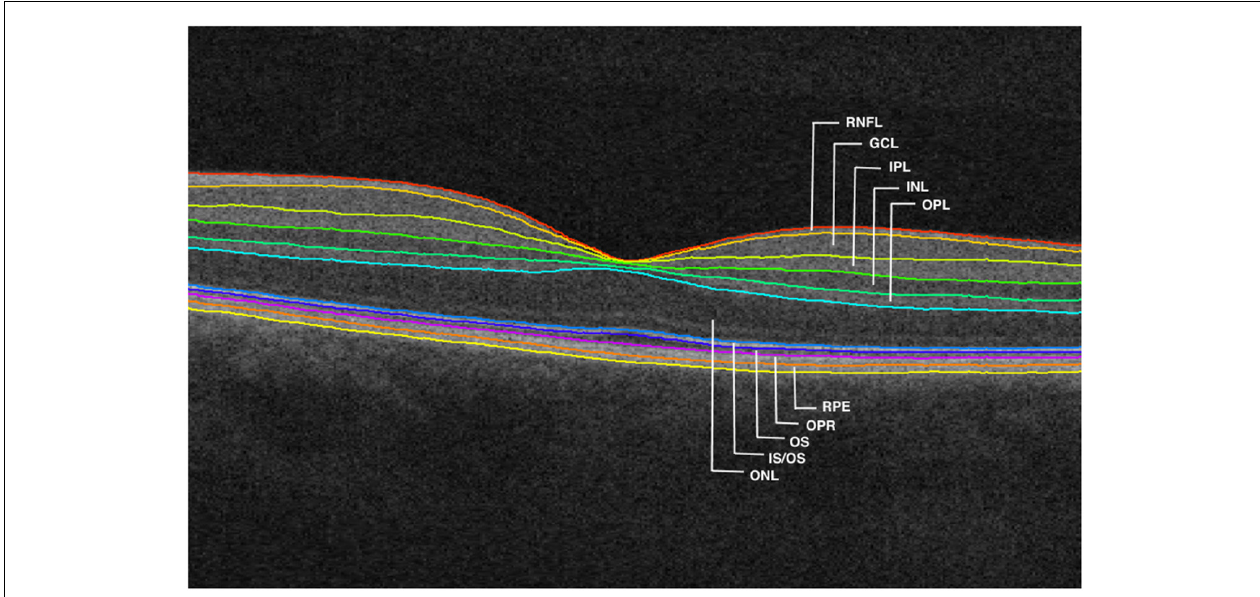
FIGURE 2 | Segmented retinal layers: retinal nerve fiber layer (RNFL); ganglion cell layer (GCL); inner plexiform layer (IPL); inner nuclear layer (INL); outer plexiform layer (OPL); outer nuclear layer (ONL); inner segment/outer segment junction (IS/OS); outer segment (OS); outer segment photoreceptor/RPE complex (OPR); retinal pigment epithelium